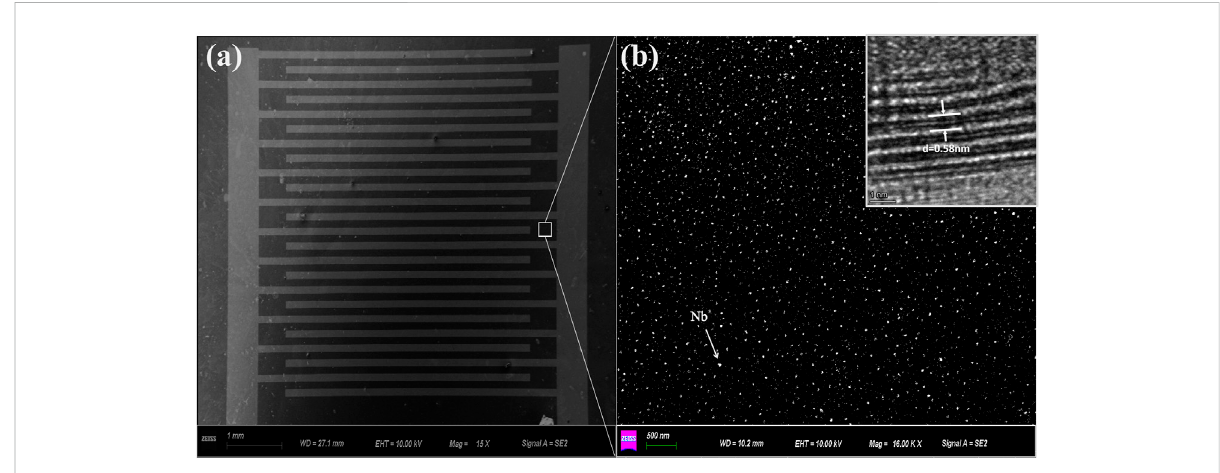
Figure 3 exhibits EDS elemental mapping of S, Mo, and